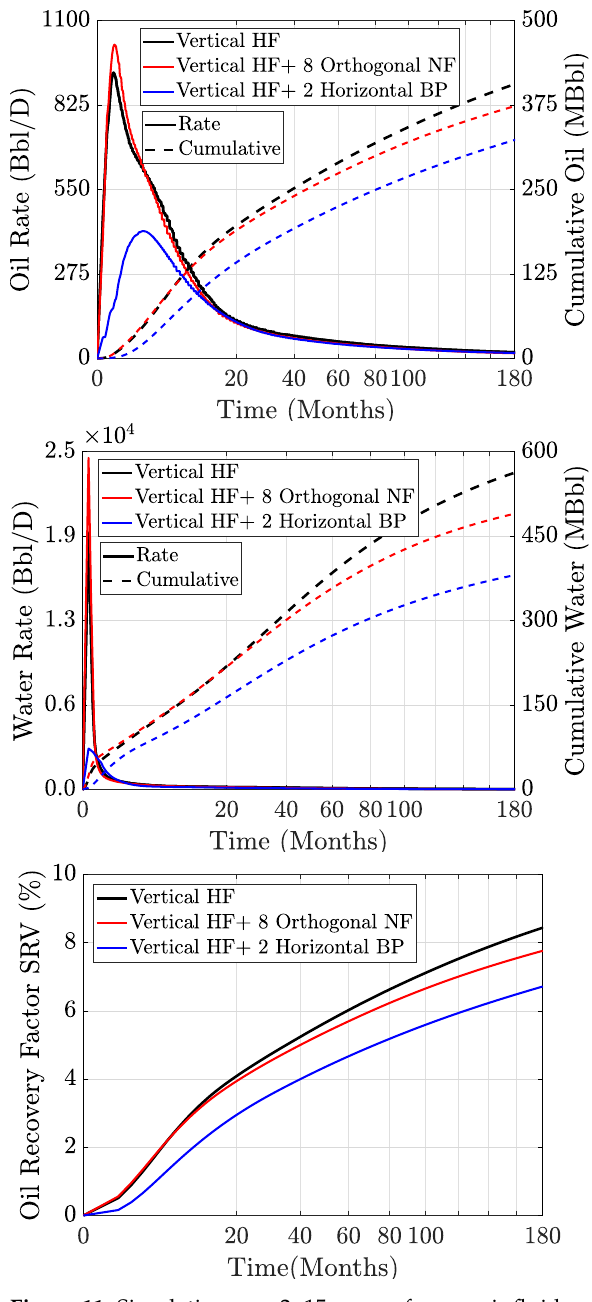
Figure 11. Simulation case 2: 15 years of reservoir fluid production obtained by varying hydraulic fracture geometry. Fracture scenario #1 is the reference case, which only has three vertical hydraulic fractures (HF) (black line). Fracture scenario #2 has three vertical hydraulic fractures and eight orthogonal natural fractures (NF) (red line). Fracture scenario #3 has three vertical hydraulic fractures and two horizontal bedding planes (BP) (blue line). The fracture scenarios #1 and #2 have a vertical hydraulic fracture permeability of 2000 mD. Fracture scenario #3 has a vertical hydraulic fracture permeability reduced by 90% (200